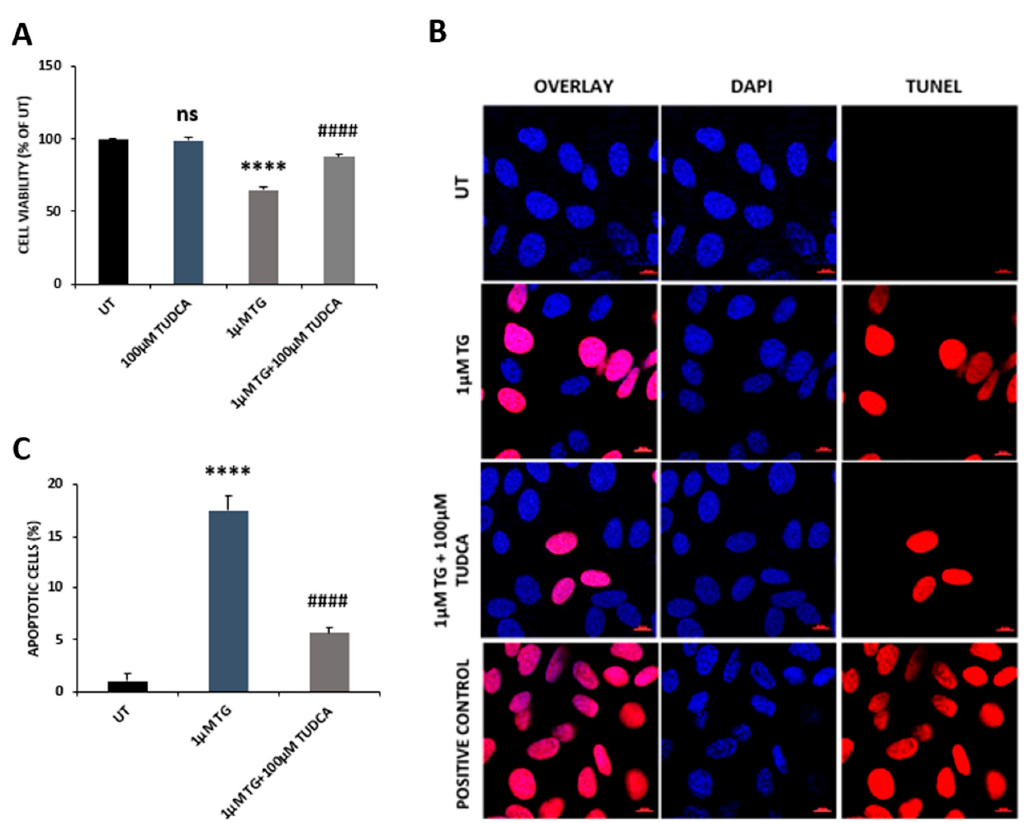
Figure 6. TUDCA counteracted the effects of thapsigargin (TG, 1µM) on ARPE-19 cell viability and apoptotic cell death. ( A ) Cell viability was examined using an MTT assay. ( B ) Apoptotic cells in control, TG, and TG-plus-TUDCA-treated cells were detected by TUNEL assay; nuclei were labeled with DAPI (scale bar, 10 µm). ( C ) The apoptotic cell rate in untreated (UT) control and treated cells was quantified. Data are shown as mean ± SEM. Ns, no significance, TUDCA vs. UT; **** p < 0.0001, 1 µ M TG vs. UT; #### p < 0.0001, 1 µ M TG plus TUDCA vs. 1 µ M